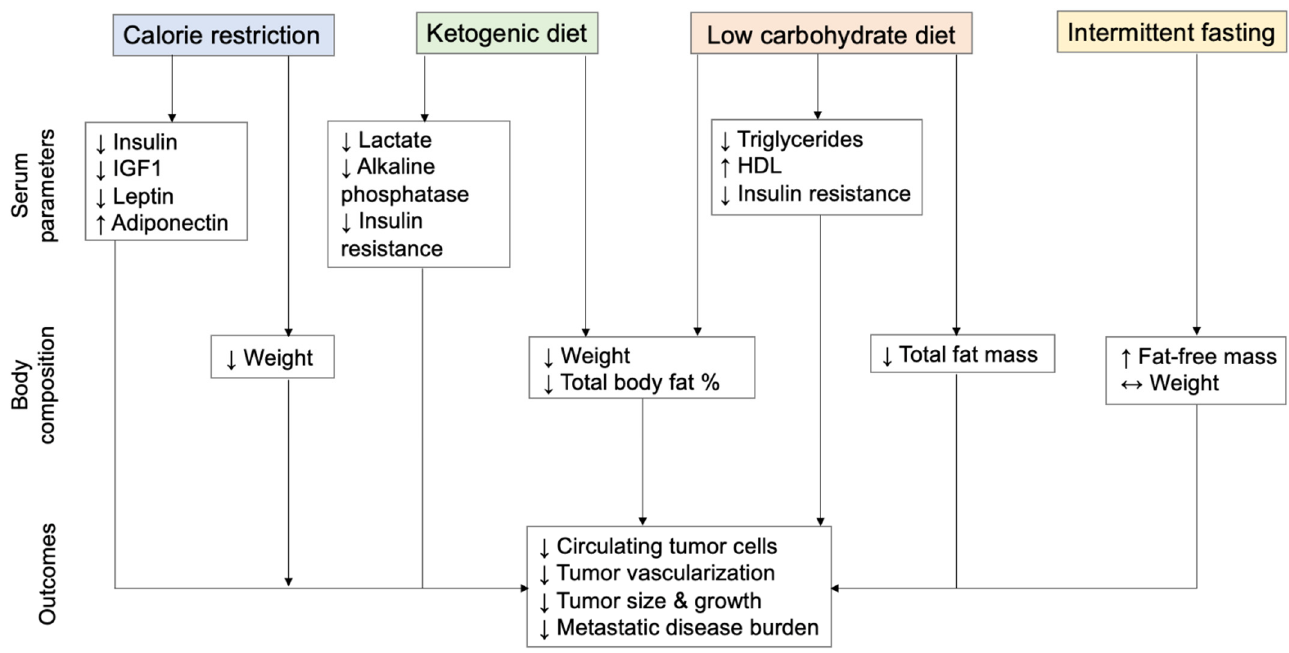
Figure 2. Effects of dietary strategies on metabolic parameters, body composition, tumor character- istics, and cancer outcomes in metastatic cancer. tics, and cancer outcomes in metastatic